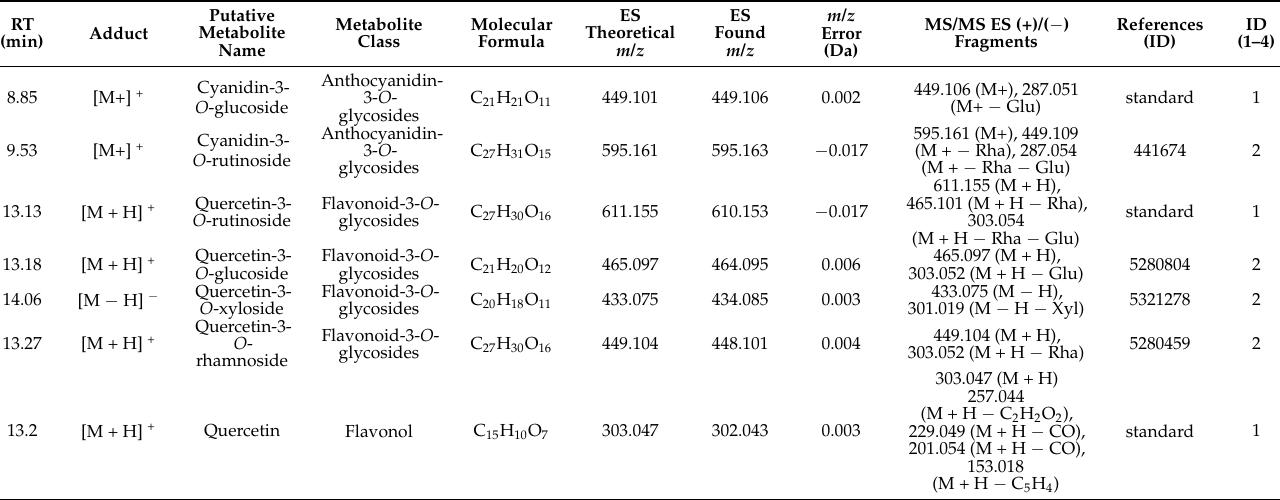
Table 2. Abundant anthocyanins and flavonoids present in Queen Garnet Plum